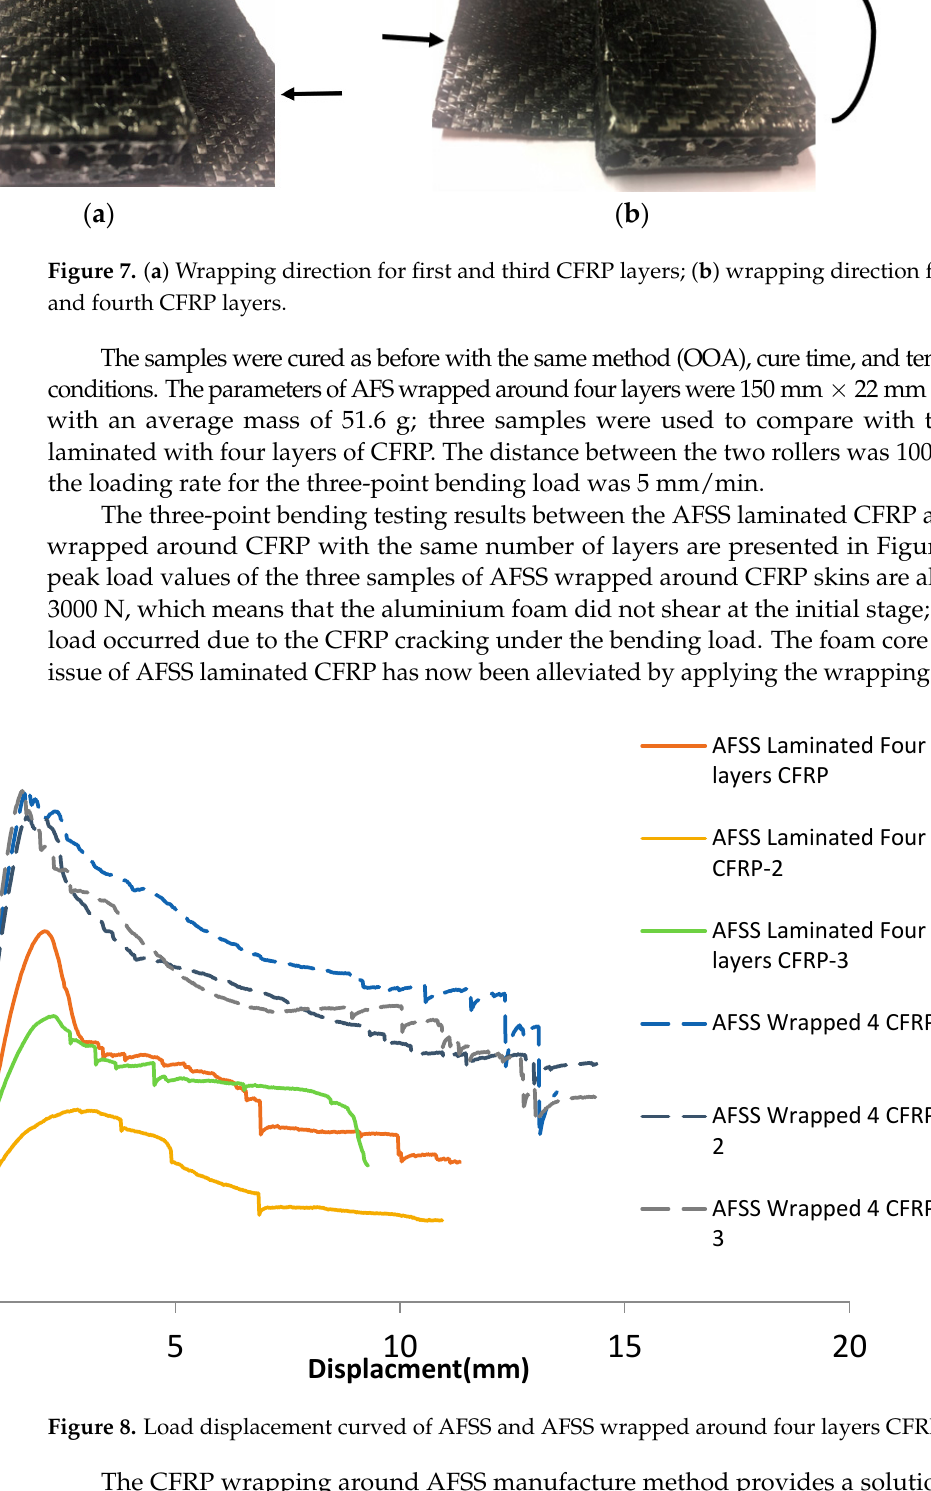
Figure 8. Load displacement curved of AFSS and AFSS wrapped around four layers CFRP.